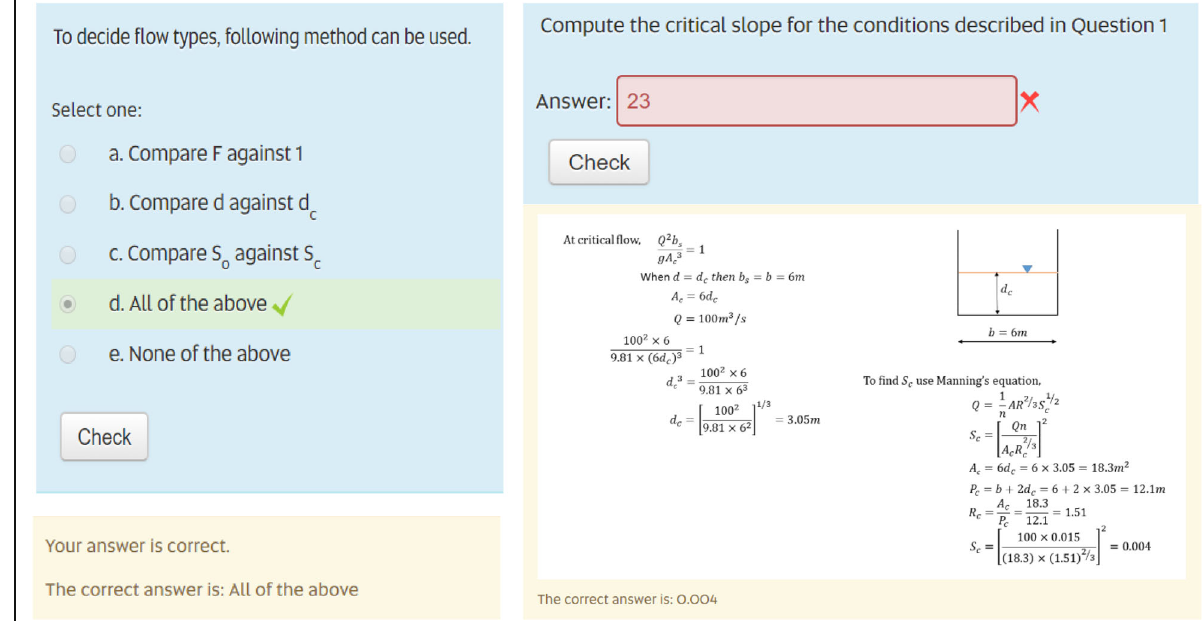
Fig. 3 Sample questions with “ Check ” button to view detailed answers